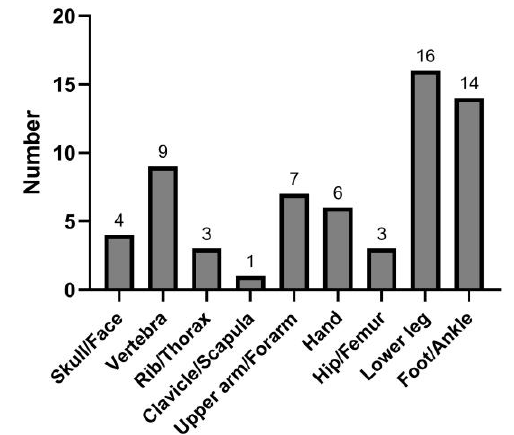
Figure 1. Cumulative incidence of fractures after kidney transplantation.